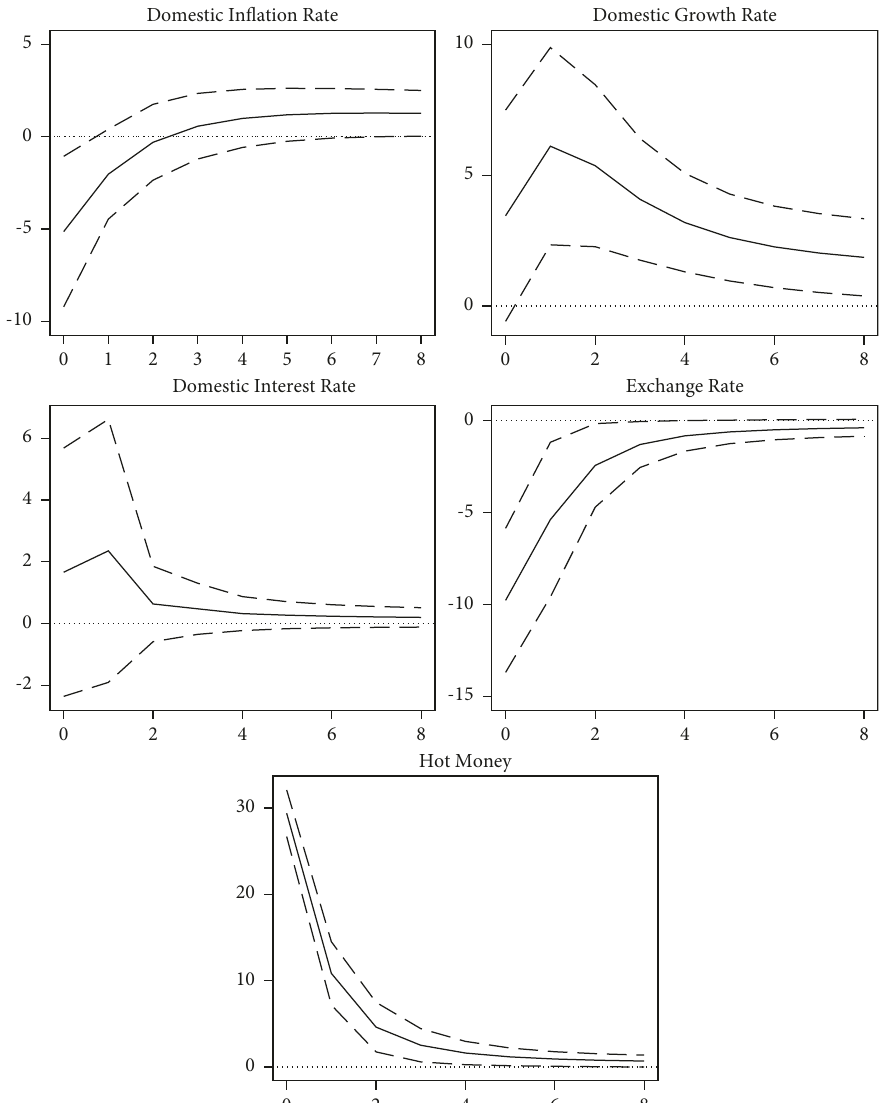
Figure 4: Impulse response functions of SVAR (alternative measurement of hot